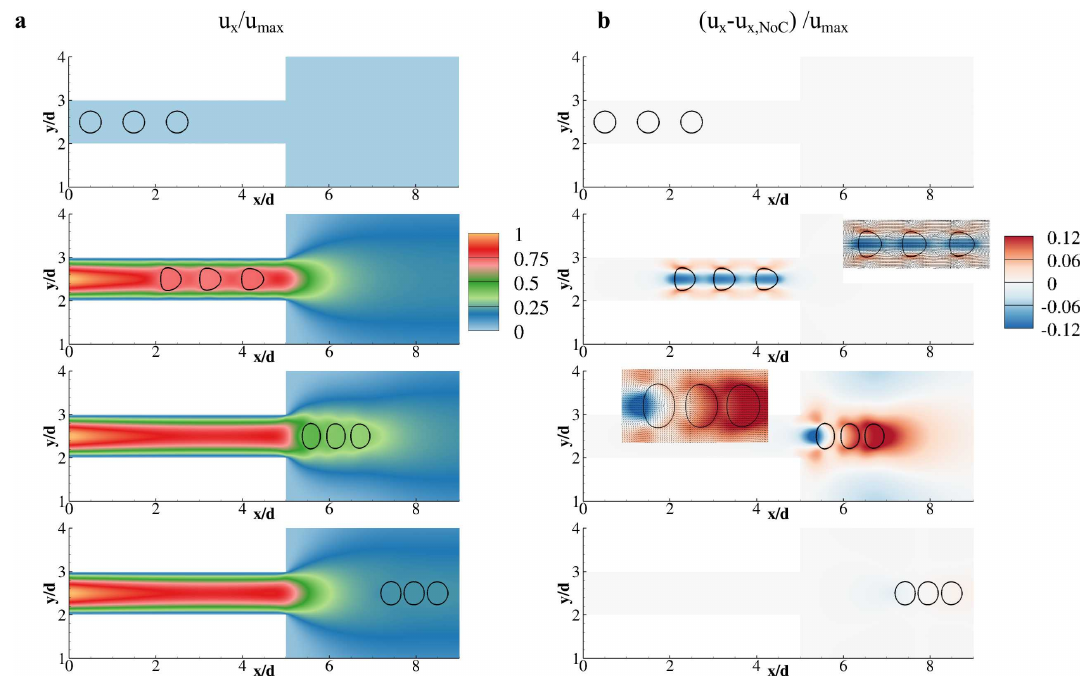
Figure 5. Flow patterns during the transport of three aligned capsules in the micro-channel. ( a ) contour of the longitudinal velocity field for l / d = 5.0 and r / d = 0.50 taken at four different time steps, namely tu max / d = 0, 5, 10, and 20; ( b ) contour plot of difference between the longitudinal velocity with ( u x ) and without ( u x , NoC ) the capsules immersed in at four different time steps, namely tu max / d = 0, 5, 10, and